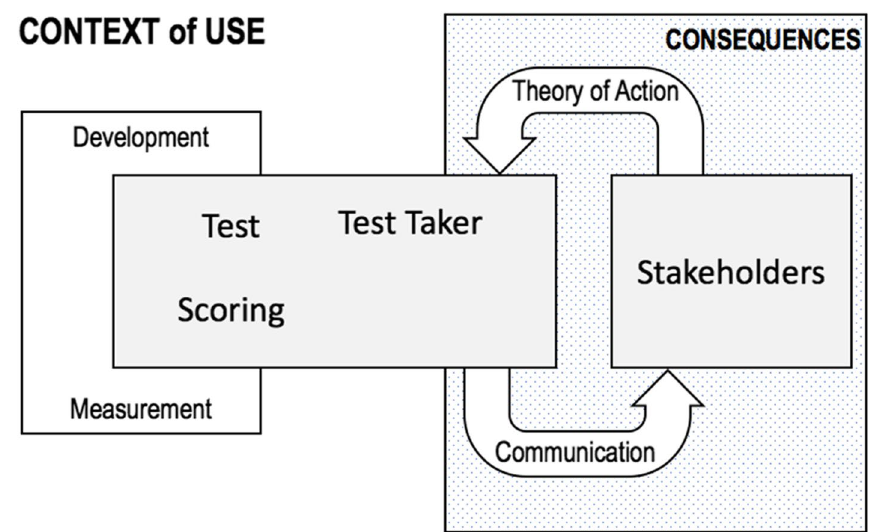
Fig. 2 Socio-cognitive model (based on Chalhoub-Deville & O’Sullivan, 2020)